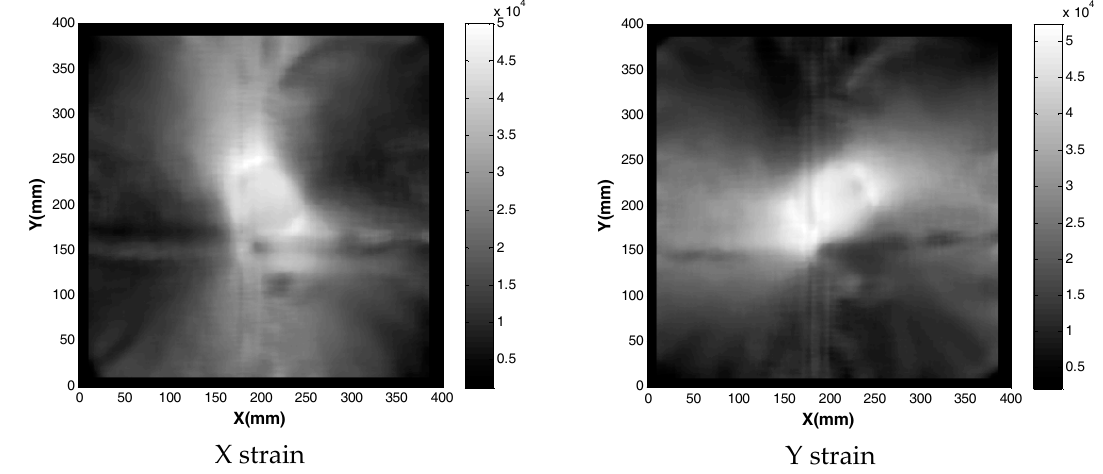
Figure 22. Strain field obtained when membrane was loaded with three spacers beneath the membrane. Table 3. Strain readings from the FE model.